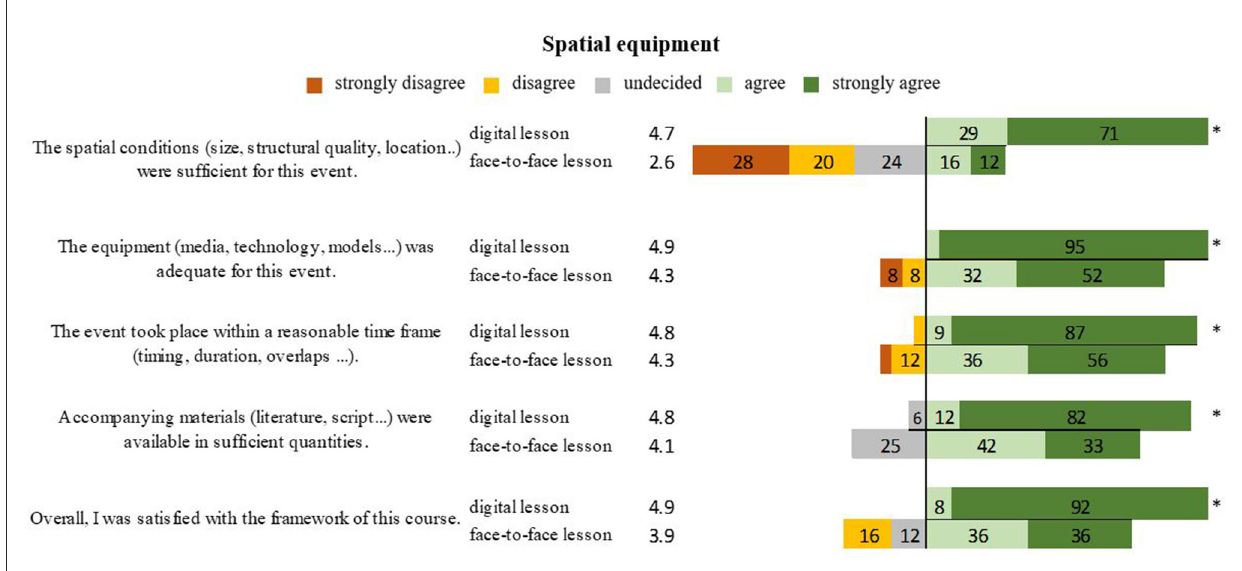
FIGURE1 Representation of students’ opinions on issues related to space in digital teaching and face-to-face teaching in percentages. *Marks significant